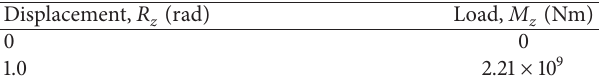
Table 9: Stiffness for 𝑀 𝑥 versus 𝑅 𝑥 ( 𝑀 𝑦 versus 𝑅 𝑦 ). Table 10: Stiffness for 𝑀 𝑧 versus 𝑅 𝑧